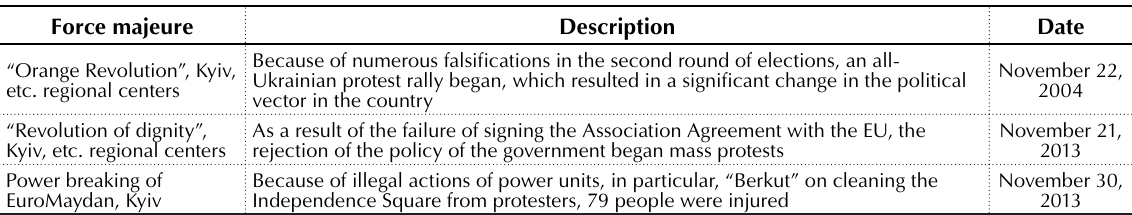
Table B1. The main social, military and political force majeure events and terrorist acts in